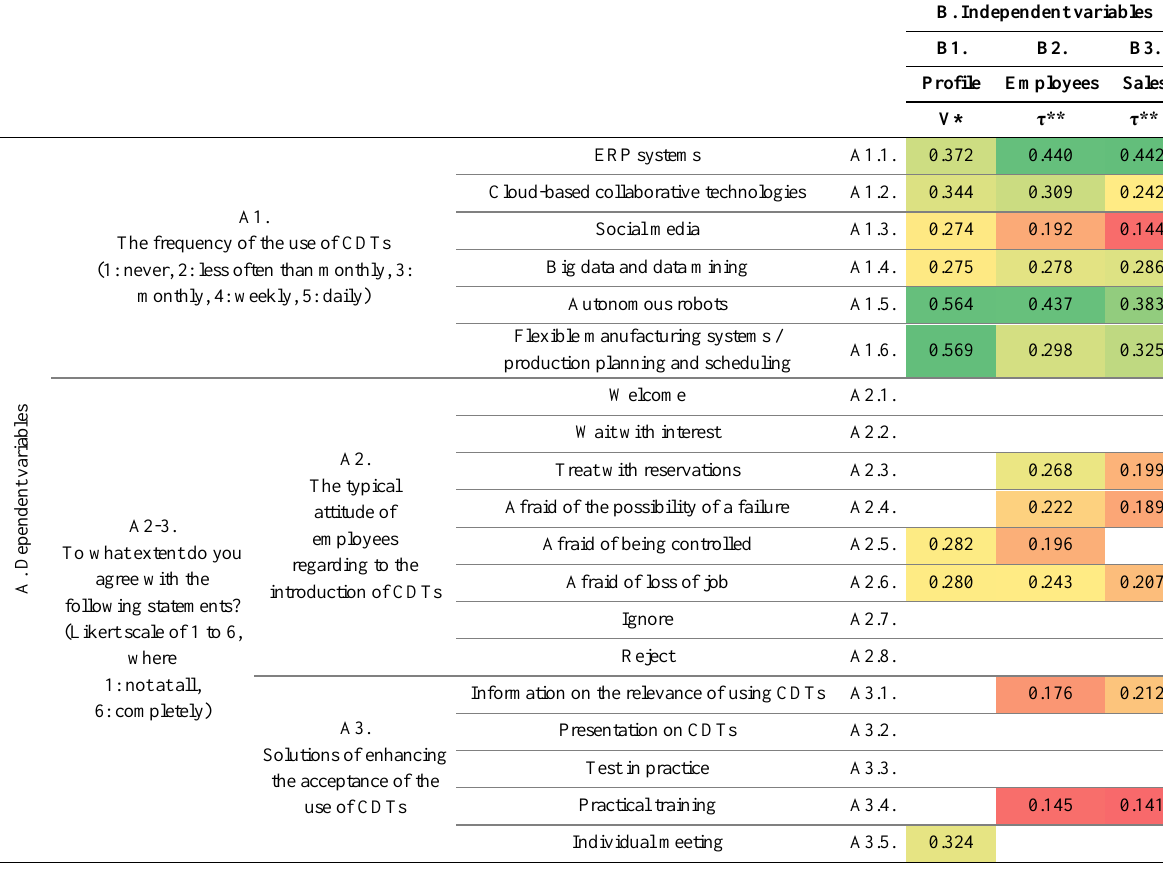
Table 1. The results of the relationship